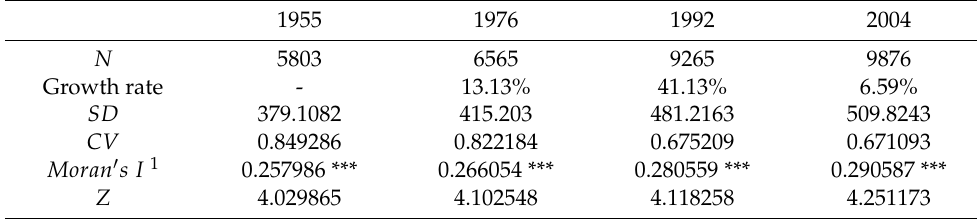
Table 2. Statistical characteristics of mosque distribution in the Kashgar region from 1955 to 2004. 1955 1976 1992 2004 N 5803 6565 9265